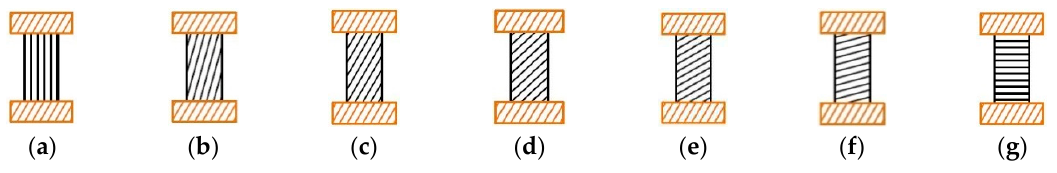
Figure 4. Schematic of standard shale samples with their inclination angles ( β ) corresponding to: